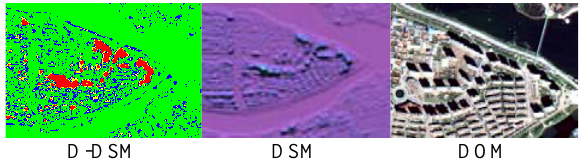
Figure 7. The high-rise building on D-DSM, DSM and DOM